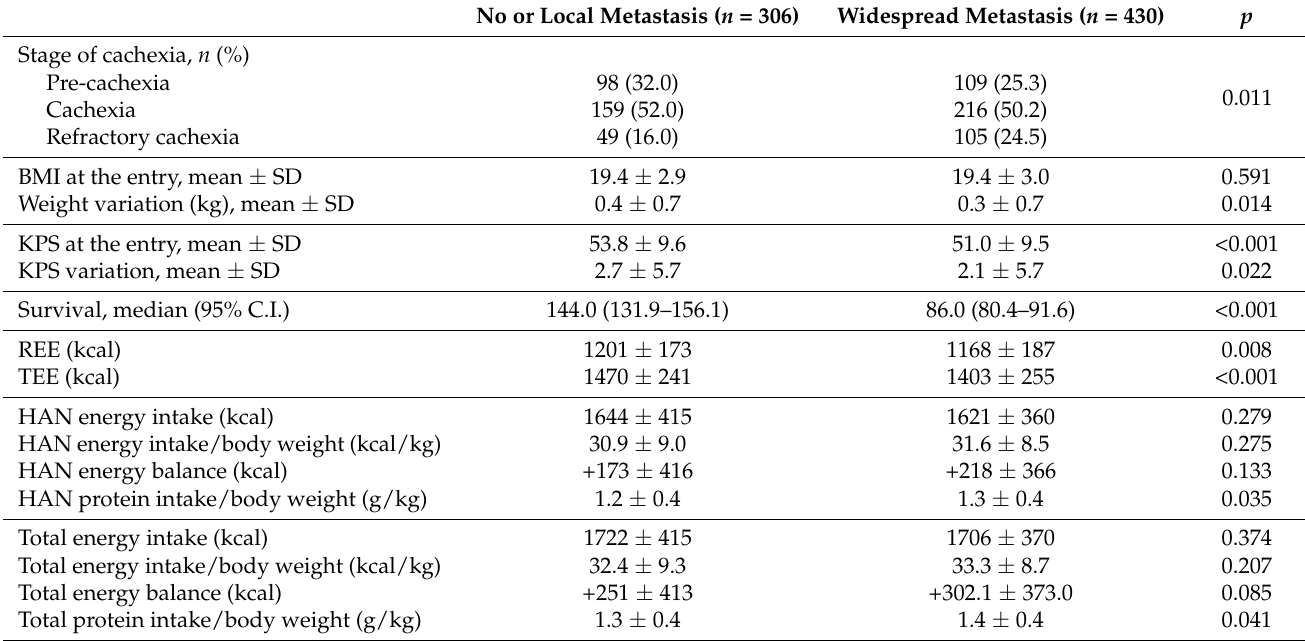
Table 4. Nutritional outcome, survival, and protein-calorie intake of patients with no or local metastasis and with widespread